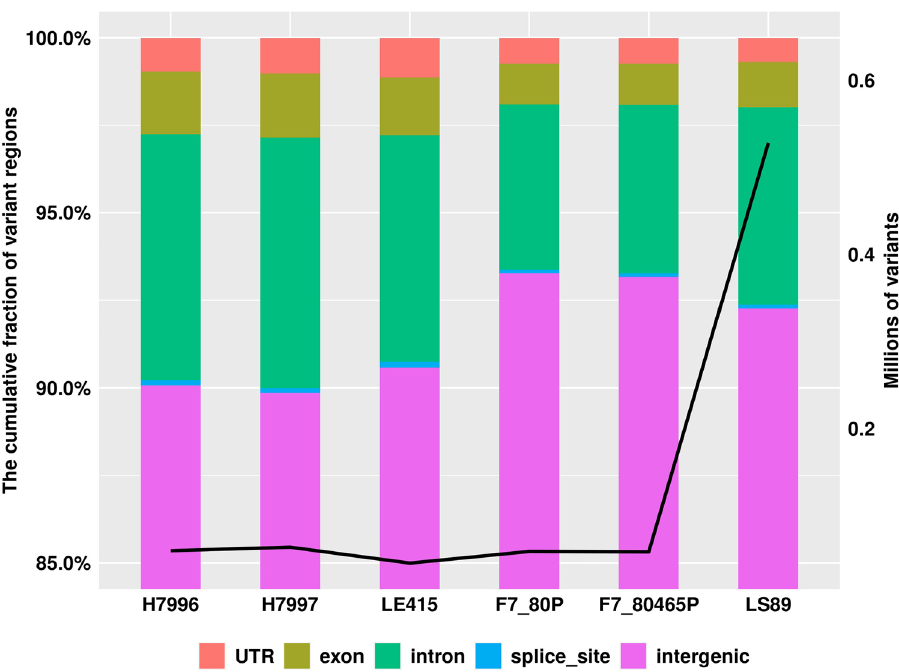
Figure 3. The proportion and number of SNPs acquired by genomic features of the six highly bacterial wilt ( Ralstonia sp.) resistant tomato lines. The bars represent the proportion of genomic features in which SNPs of tomato lines are located, and the black line is the number of SNPs contained in each of the tomato lines. In the legend, “UTR” includes 5 ′ UTRs and 3 ′ UTRs, and “splice_site” includes the donors, receptors and regions of splice